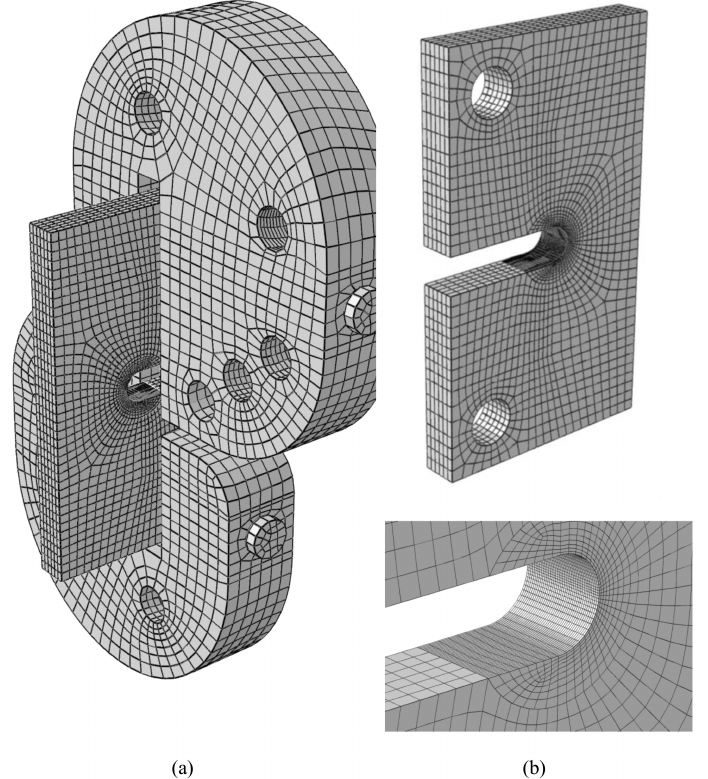
Figure 6. Finite element model. ( a ) Fixture and specimen configuration; ( b ) meshed